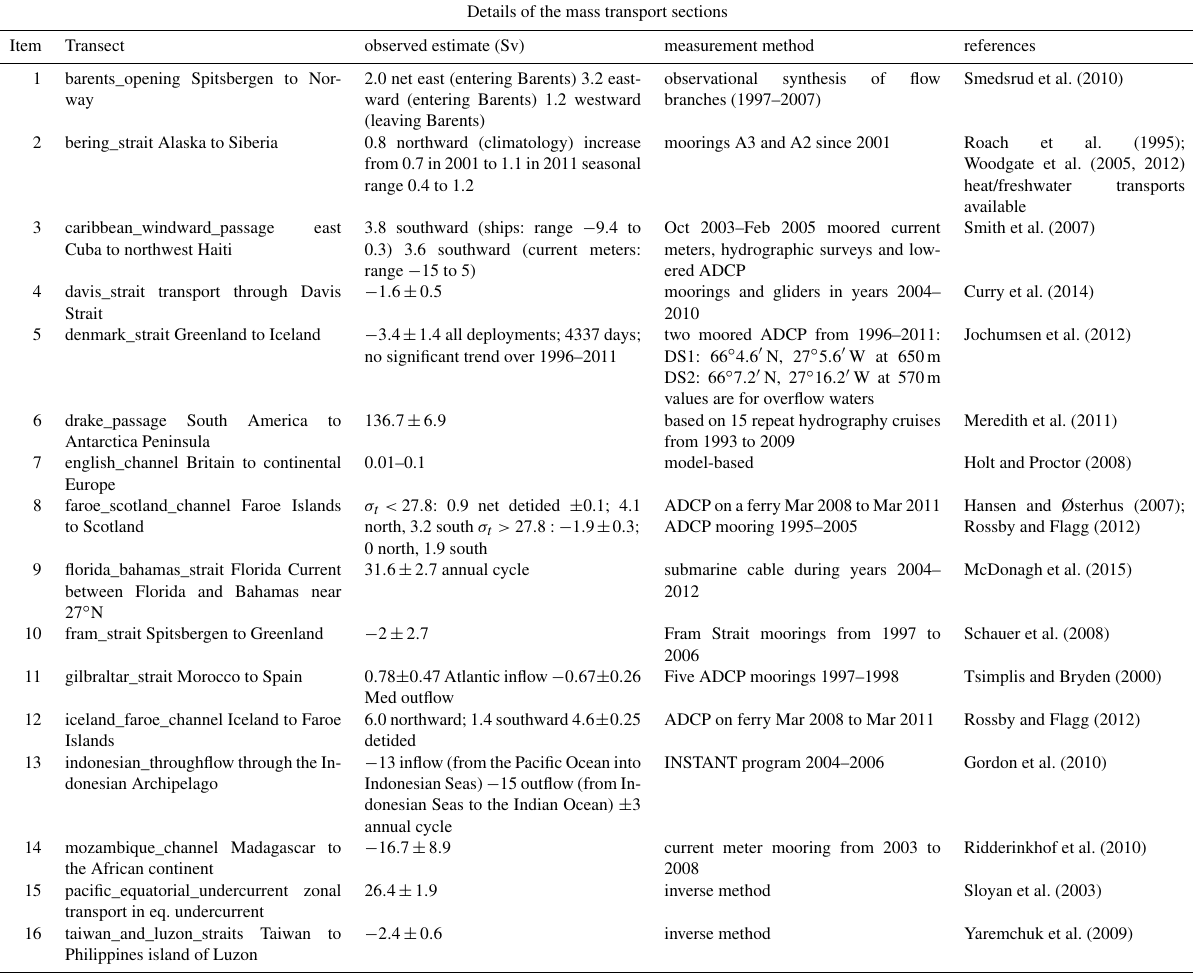
Table J2. This table details the mass transport sections from Table J1, including observational-based measures, measurement methods,